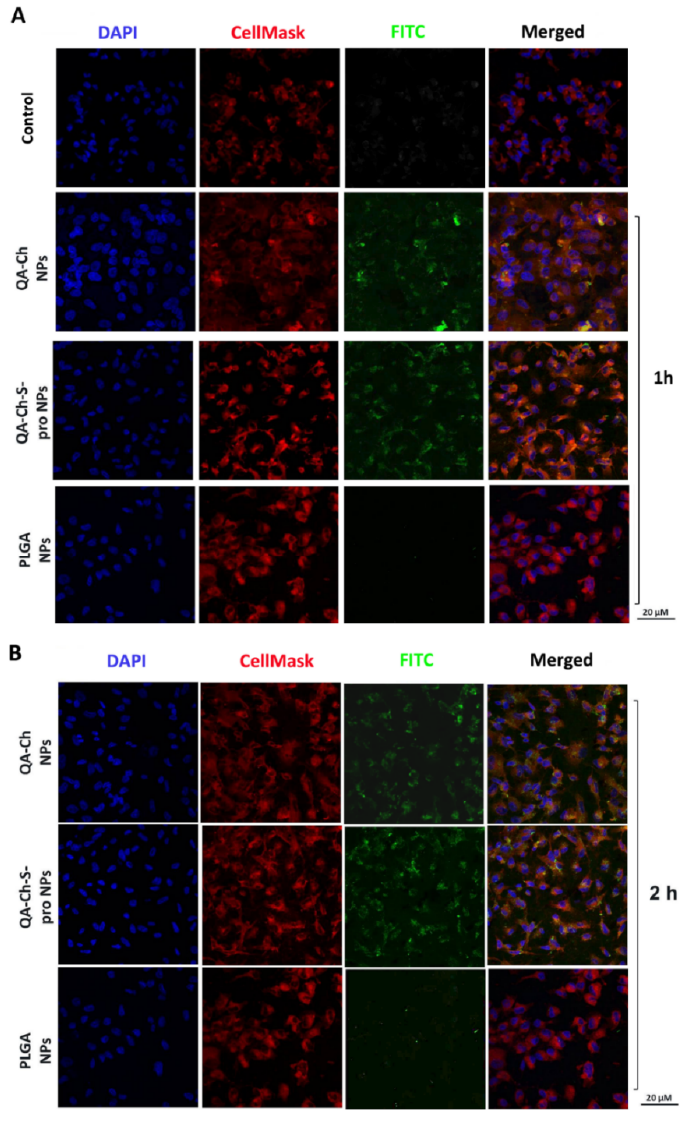
Figure 6. Confocal fluorescence microscopy analysis of HUVEC incubated with FITC-labeled QA-Ch, QA-Ch-S-pro, or PLGA NPs (green color) for 1 h ( A ) or 2 h ( B ). CellMask and 4,6-Diamidino-2-phenylindole (DAPI) for staining the cellular membrane and nucleus are shown in red and blue colors, respectively. Scale bars are 20 µm. Control is represented by untreated cells.